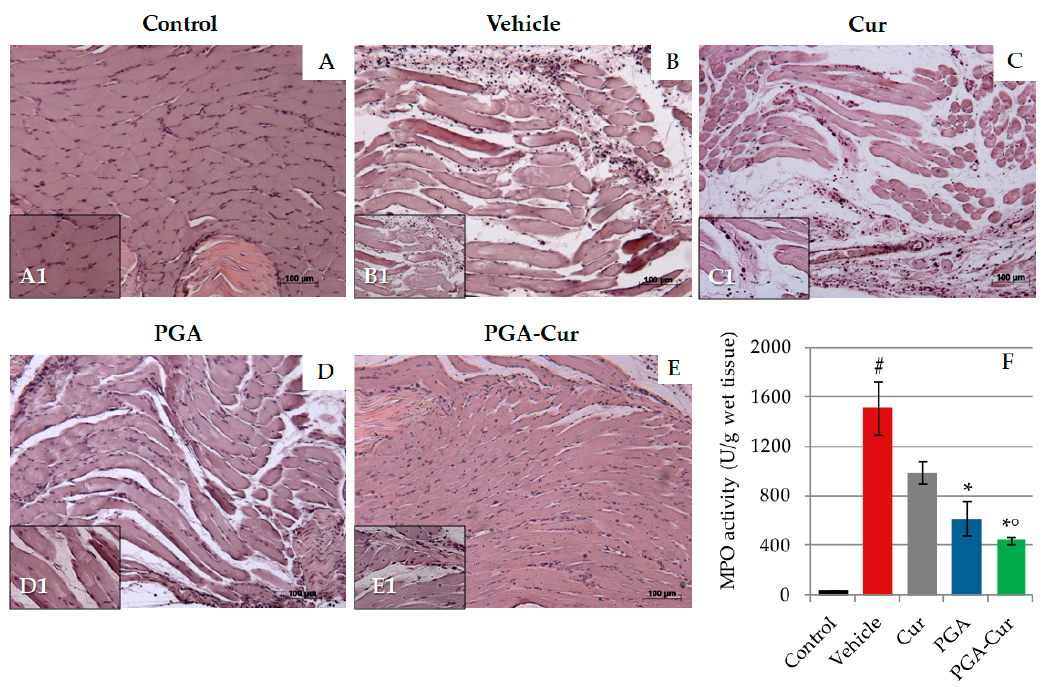
Figure 2. Anti-inflammatory effect of the study compounds in CAR-injected paw. Representative images of H/E-stained paw sections ( A–E ). Intraplantar injection of CAR-induced marked edema and cellular infiltration ( B ) compared to control animals ( A ). Histopathological changes appeared not to benefit from a single dose of curcumin ( C ), while PGA administration counteracted both tissue edema and cellular infiltration ( D ). The co-micronized formulation (single administration, 30 min prior to CAR) prevented almost completely the inflammatory changes ( E ). The histological findings mirrored the neutrophil infiltration into the paw as measured by myeloperoxidase (MPO) activity ( F ). Values are means ± standard error of the mean of 6 animals for each group. Cur = curcumin; PGA = micronized palmitoyl-glucosamine; PGA-Cur = co-micronized palmitoyl-glucosamine and curcumin. # p < 0.05 vs. control; * p < 0.05 vs. vehicle; ° p < 0.05 vs. Cur. The p values are reported in the text.